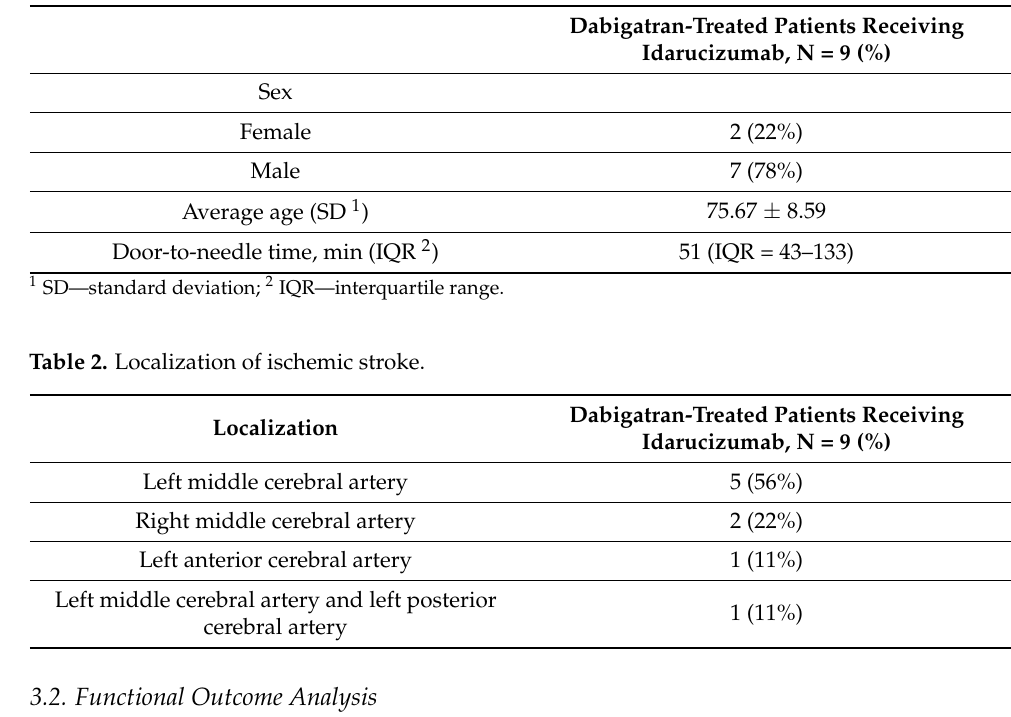
Table 1. Demographic data of patients and door-to-needle times.